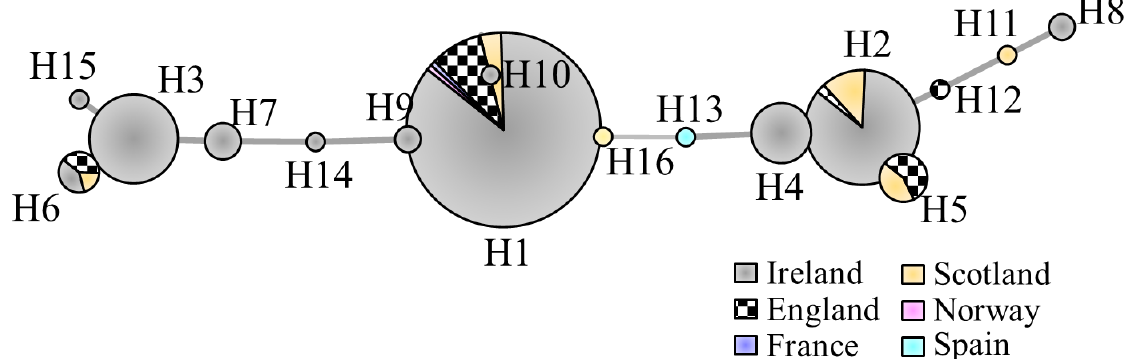
Figure 4. MSN based on Euclidean squared distances between haplotypes. Node size corresponds to the relative abundance of each haplotype.